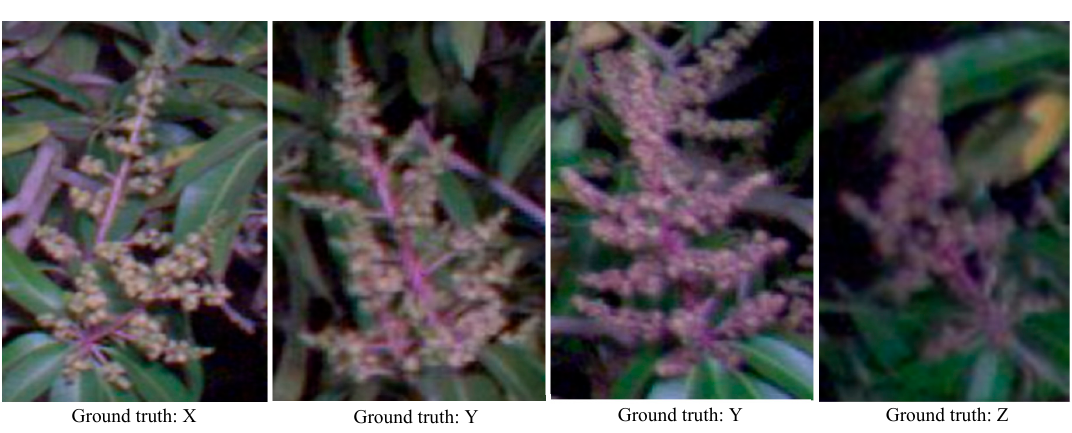
Figure 7. Representative examples of differences in classification from YOLO and R 2 CNN models. Ground truth and predicted results by YOLO and R 2 CNN, respectively: ( a ) X, X, Y, ( b ) Y, X, Y, ( c ) Y, Z, Y, and ( d ) Z, Y, Z.